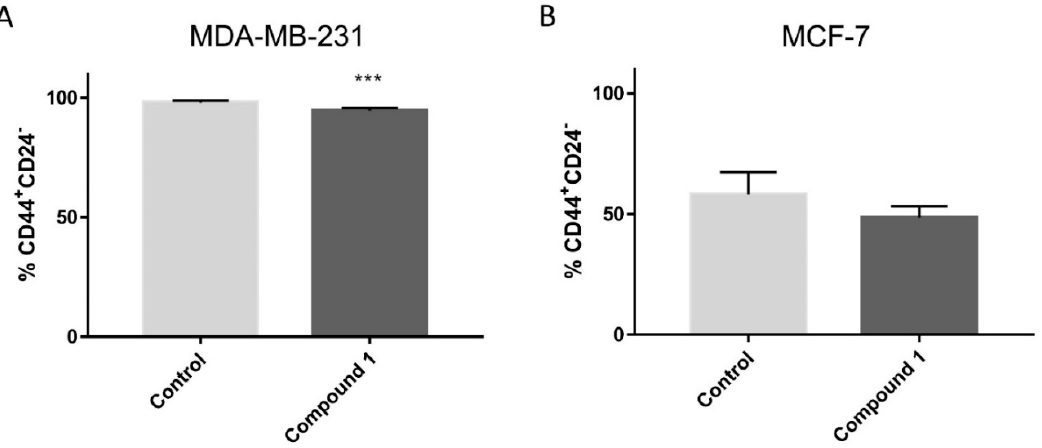
Figure 4. CSCs after compound 1 treatment. Notes: Percentage of CD44 + CD24 − CSCs after treatment with compound 1 for 48 h in MDA-MB 231 ( A ) and in the MCF-7 cell line ( B ). Data represented are expressed as a mean from experiment performed in triplicate ± SD. Columns, mean of cells; bars, SD; *** p < 0.001. CSCs cancer stem cells; SD, standard deviation.